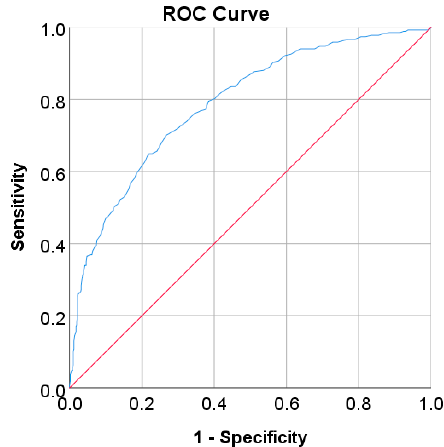
Figure 9. ROC curve for FBS values as a screening test on the Korean adult population; FBS was used as the gold standard; the straight line represents the reference line.